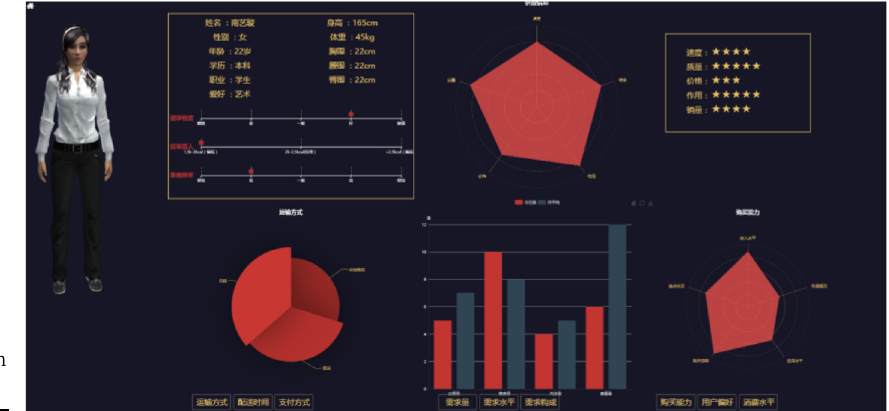
Figure 7. “ Who am I ” function